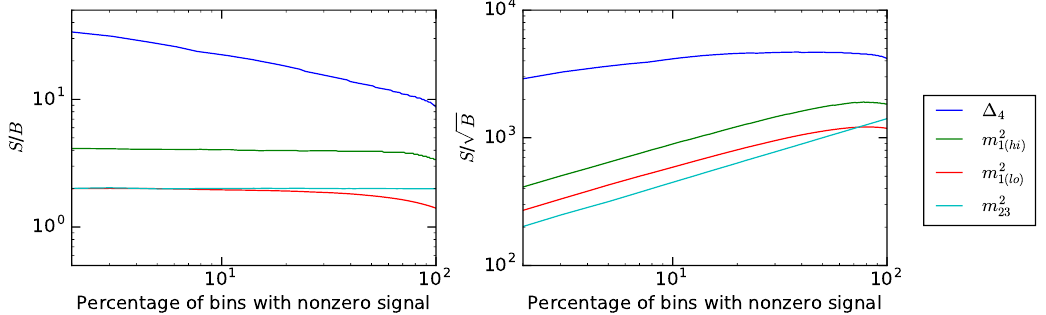
Figure 7 . The same as (cid:12)gure 4, but taking the (cid:12)nite energy resolution and combinatoric e(cid:11)ects into